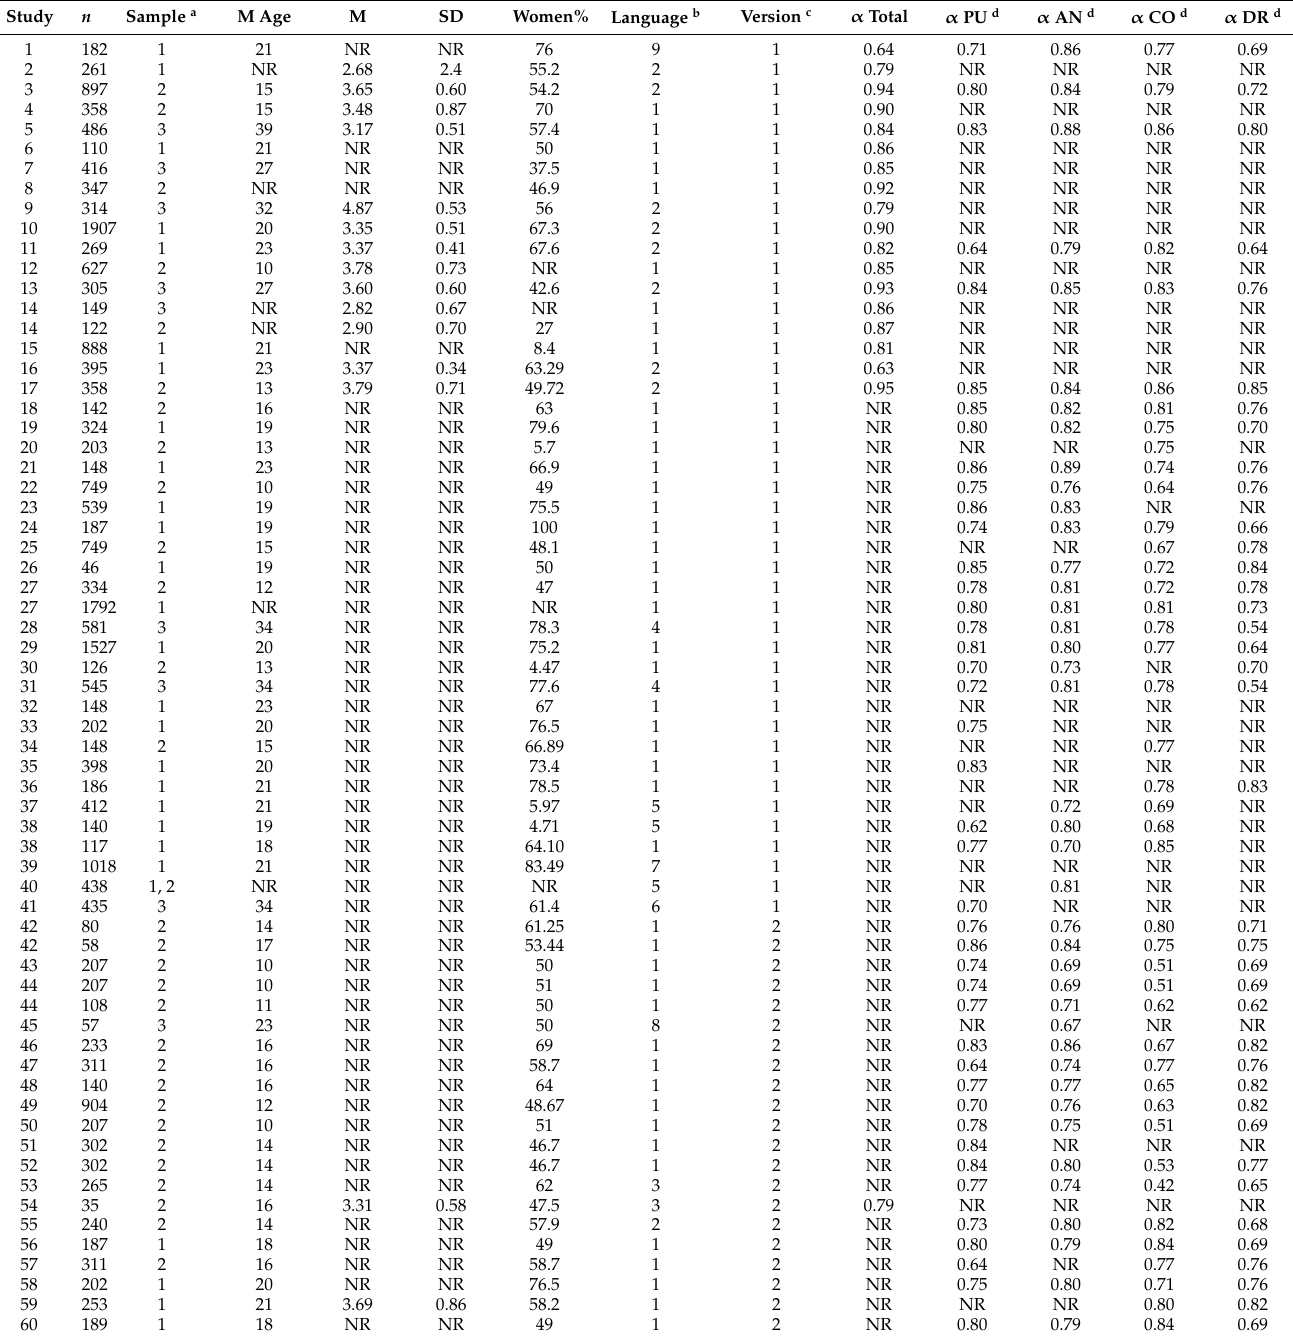
Table 1. Main statistics of the 60 studies included in the